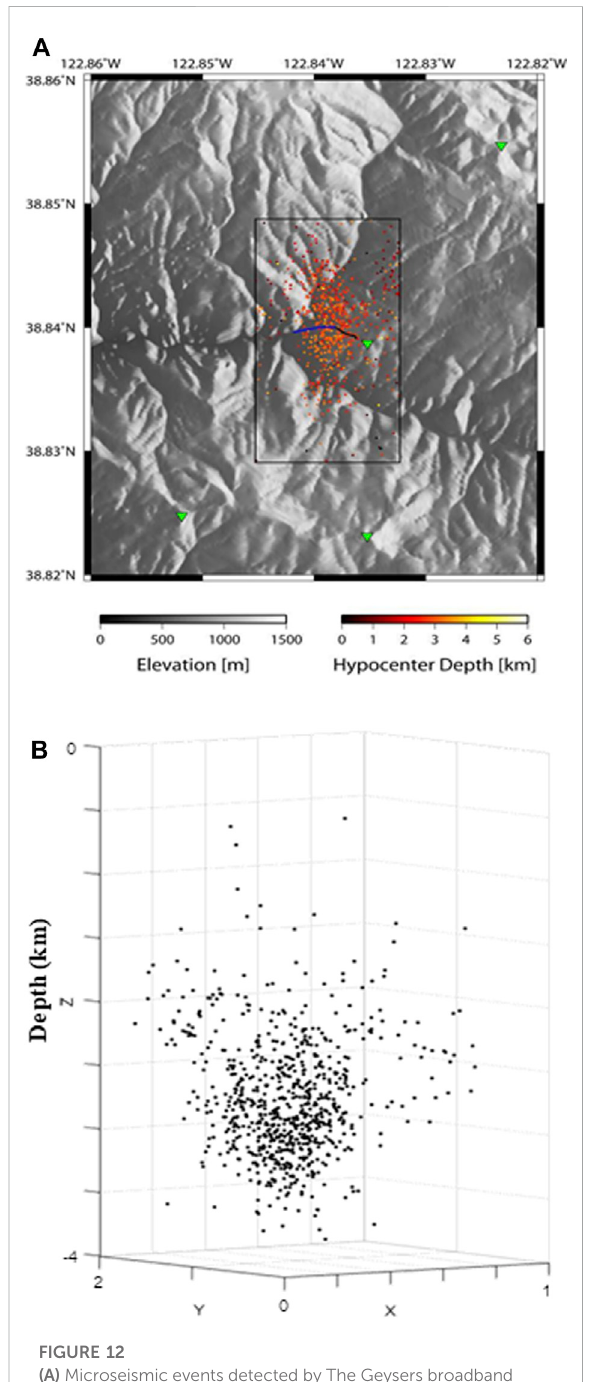
FIGURE 13 (A) Fracture network imaging results obtained using the GARNET algorithm with microseismic location and orientation data. (B) Statistical representation of the generated fracture networkbelowproductionwell(red)andinjectionwell(blue), adapted from Gritto et al.